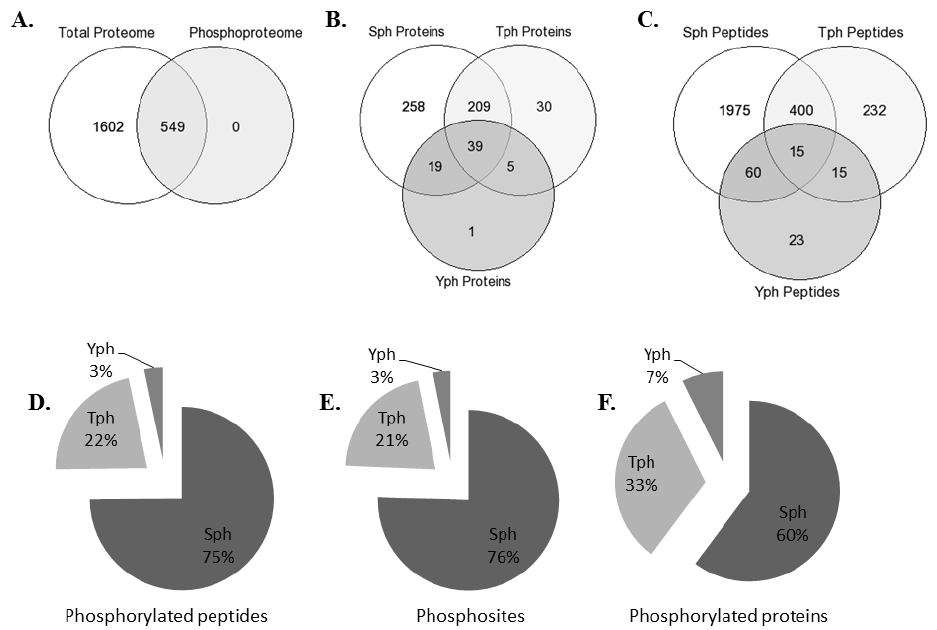
Figure 2. Statistical overview of total and phosphoproteome. ( A ) Overlap between proteome and phosphoproteome. ( B ) Overlap between phosphorylated serine, threonine, and tyrosine containing phosphoproteome. ( C ) Overlap between serine, threonine, and tyrosine phosphorylated peptides. ( D ) Phosphorylated peptides distribution. ( E ) Phosphosites distribution. ( F ) Phosphorylated proteins distribution.